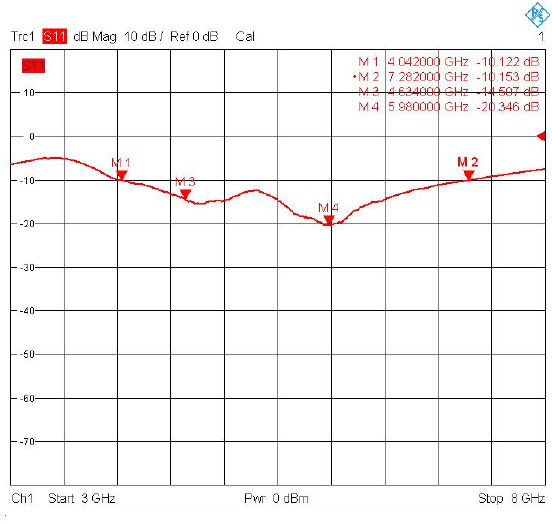
Figure 8. (a) Top view of the proposed geometry (b) Back view of theproposedgeometry(c)Topviewofdesignedgeometry (d) Back view of designed geometry